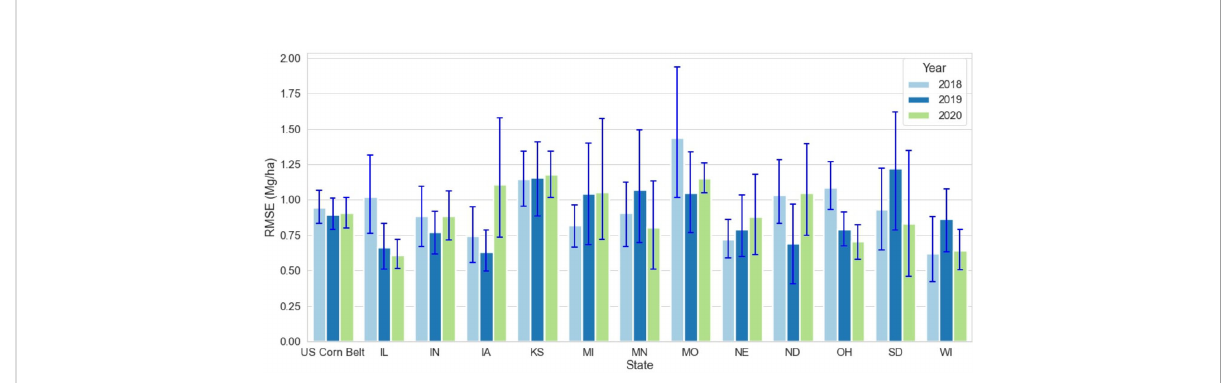
FIGURE 4 State-wise RMSE for optimized weighted ensemble model from the year 2018 to 2020. The blue lines demonstrate the range of RMSE for each state at the crop reporting district level for each year. MO had the highest RMSE in 2018 IL had the lowest RMSE in 2020.